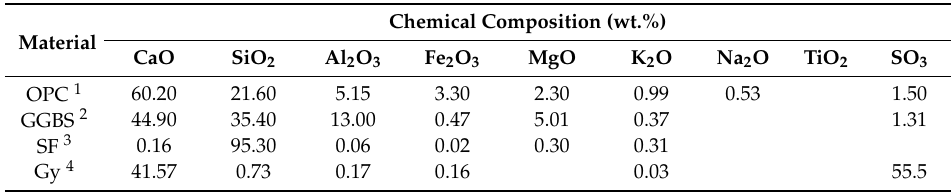
Table 1. Chemical compositions of the binders.